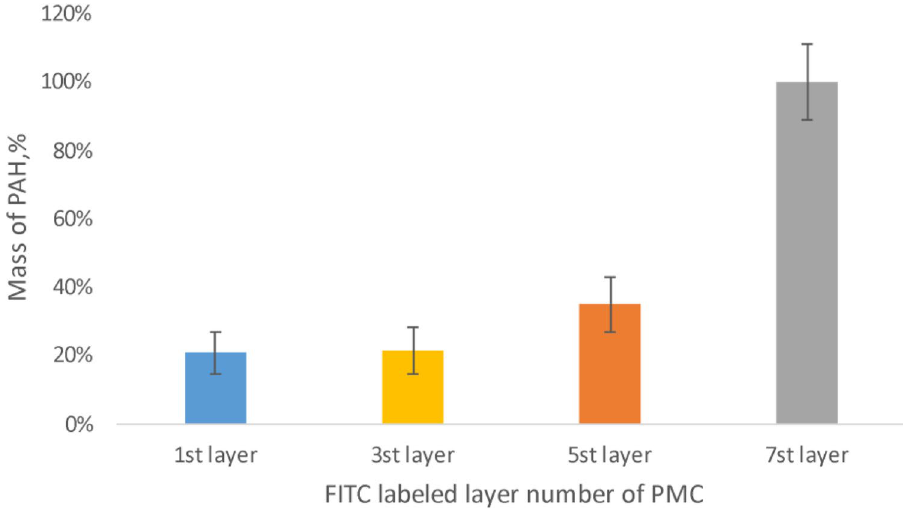
Figure 5. Dissociation of polyelectrolyte layers of microcapsules contained protein, incubated in 2 M NaCl